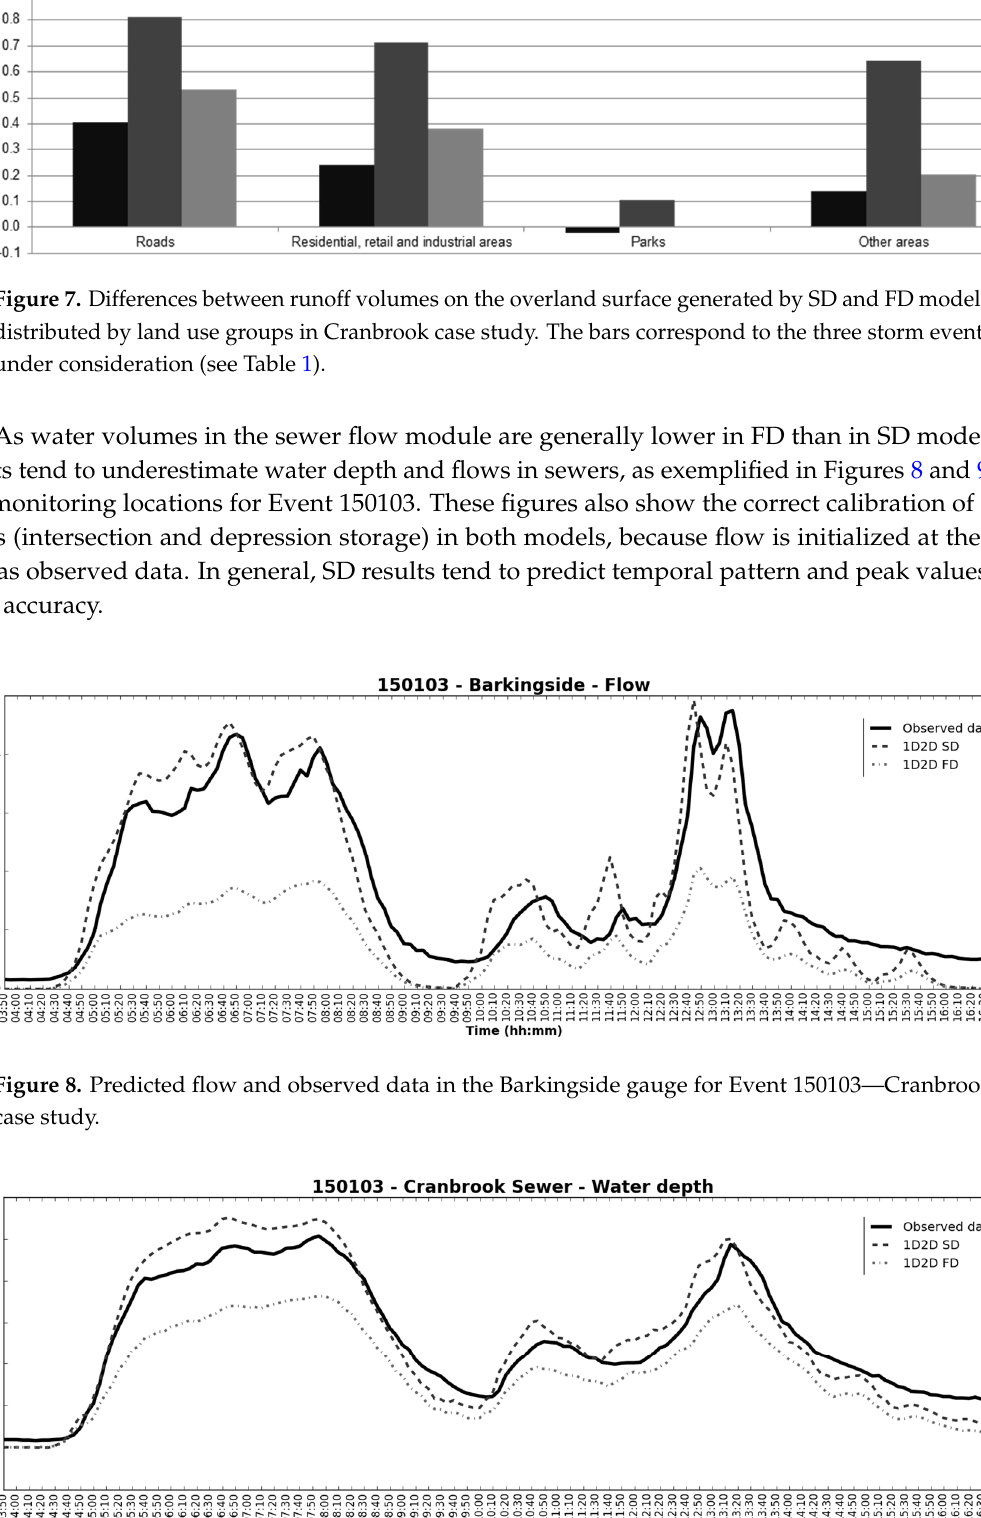
Figure 9. Predicted water depth and observed data in the Cranbrook Sewer gauge for the Event 150103—Cranbrook case study.